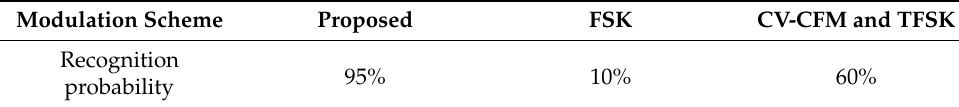
Table 1. The result of the DoM evaluation.